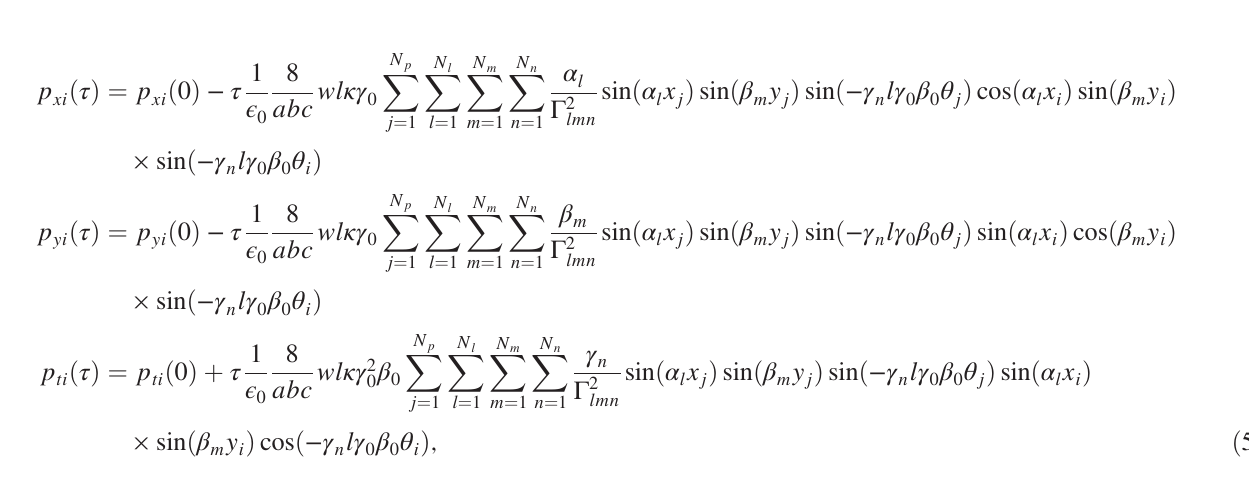
FIG. 7. Relative transverse electric field difference along x-axis (left) and longitudinal electric field difference along z-axis (right) from the gridless spectral method and the spectral-finite difference